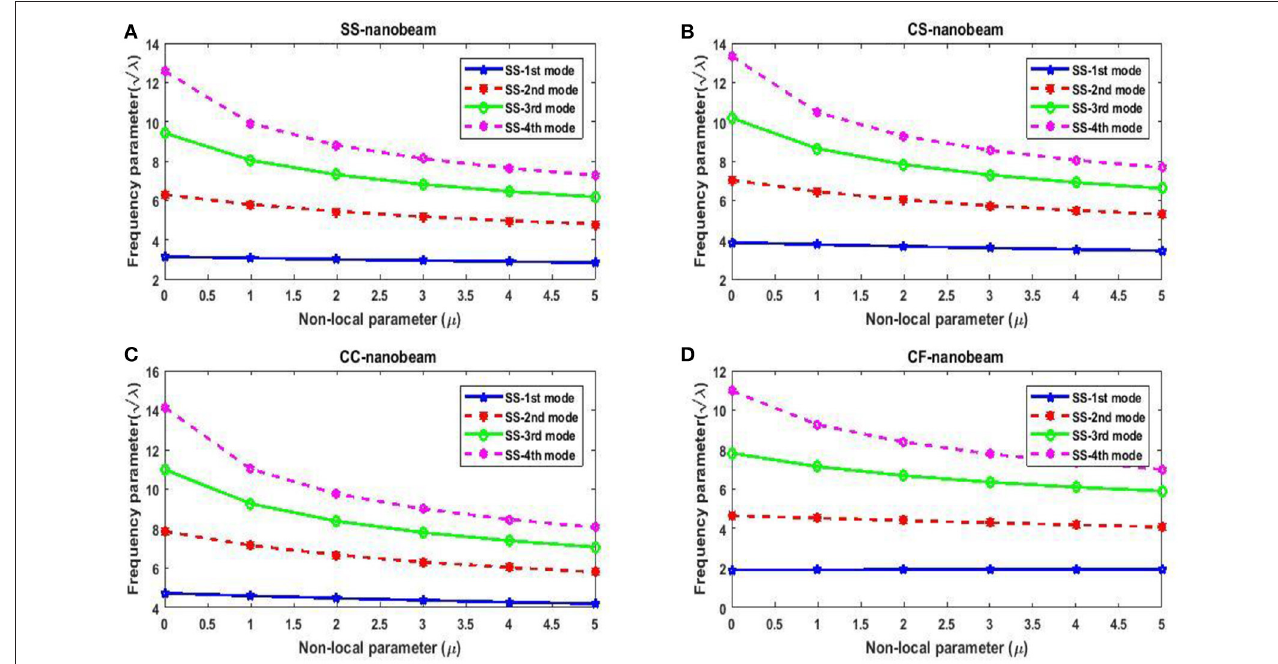
FIGURE 2 | Variation of frequency parameter with nonlocal parameter. (A) Variation of Nonlocal parameter for SS Nanobeam. (B) Variation of Nonlocal parameter for CS Nanobeam. (C) Variation of Nonlocal parameter for CC Nanobeam. (D) Variation of Nonlocal parameter for CF Nanobeam.